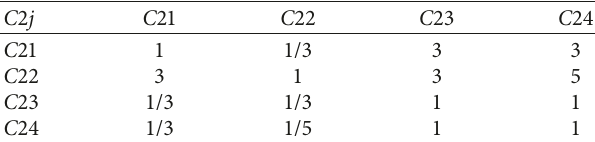
Table 6: Judgment matrix of C 2 j .